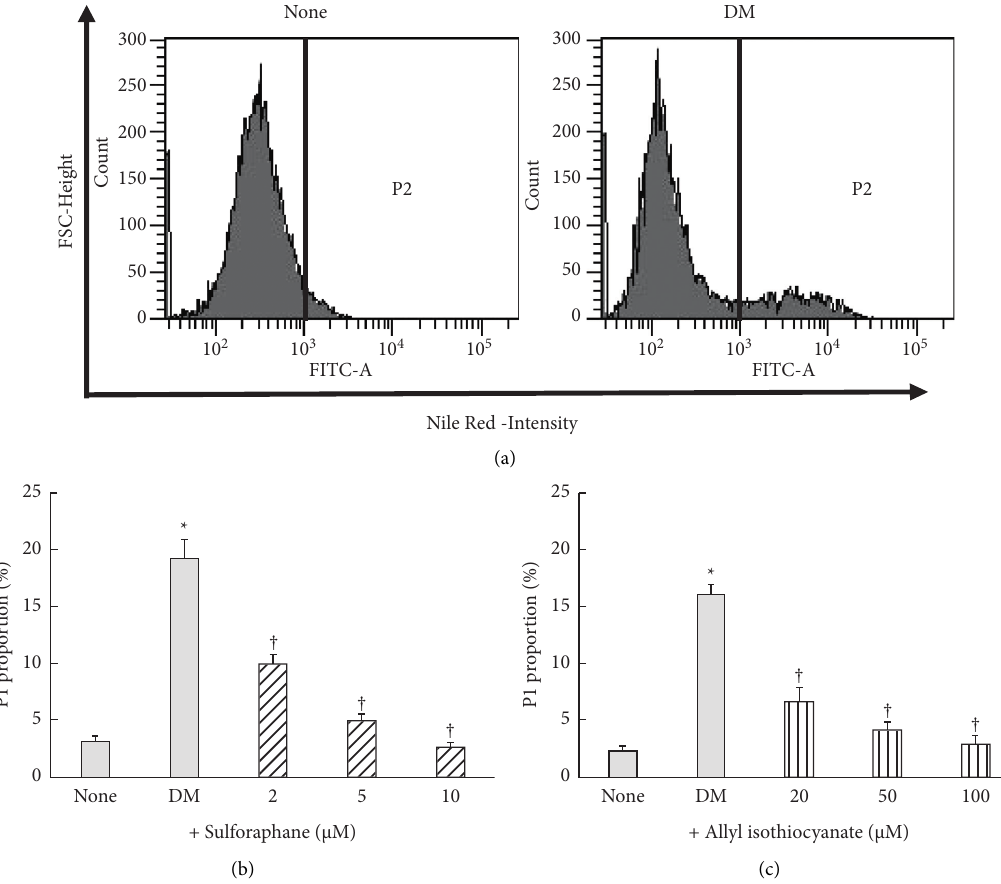
Figure 4: Results of Nile Red staining and flow cytometry analysis of 3T3-L1 adipocytes treated with sulforaphane (b) or allyl isothiocyanate (c). (a) Representative images showing results of the flow cytometry analysis using Nile Red staining. Data are presented as the mean- ± standard error ( n � 5). ∗ denotes P < 0 . 01; † denotes P < 0 . 01, versus untreated cells (none) or cells cultured in differentiation medium (DM), respectively. FSC denotes forward